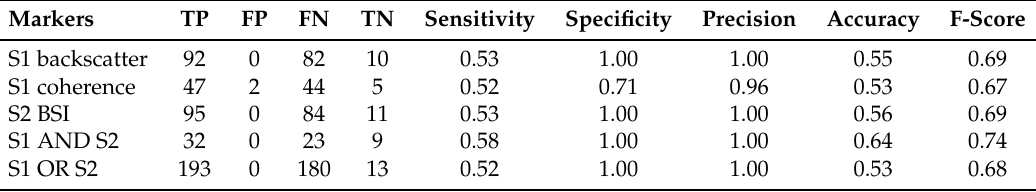
Table 13. Markers’ assessment through street-level pictures and the corresponding metrics: TP, FP, FN, TN, sensitivity, specificity, precision and accuracy (TP: True Positive, FP: False Positive, FN: False Negative, TN:True